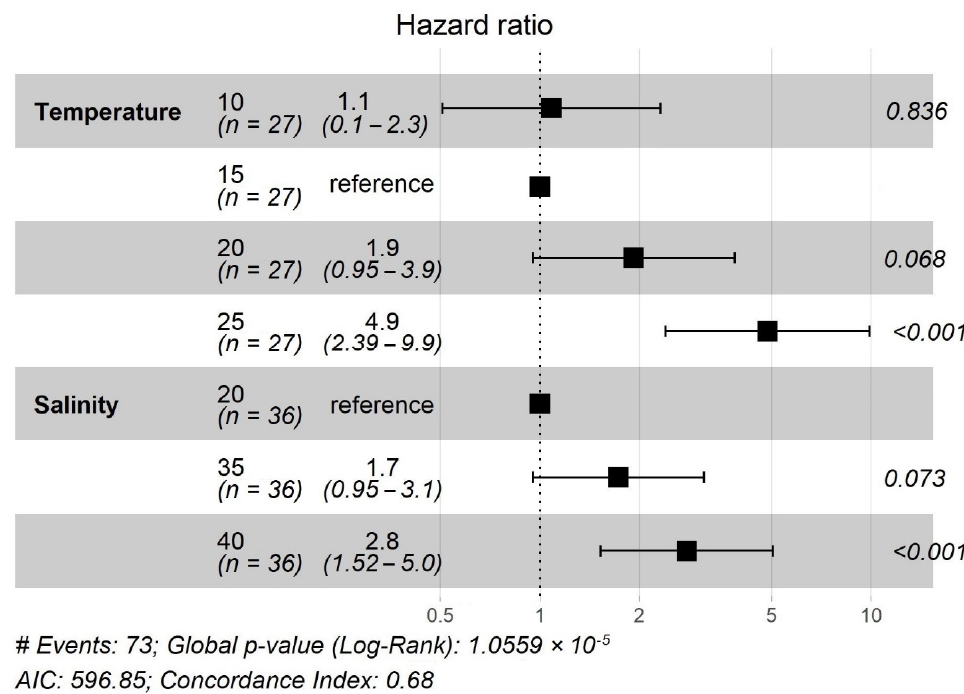
Figure 5. Hazard ratios of Aurelia solida ephyrae that were kept at twelve different combinations of temperatures and salinities over 21 days of the experiment ( n = 9 per combination). Numbers and horizontal bars represent the ratio and the 95% confidence interval, respectively. p -values display statistical differences between each group and the reference group (15 °C and 20 psu, respectively).